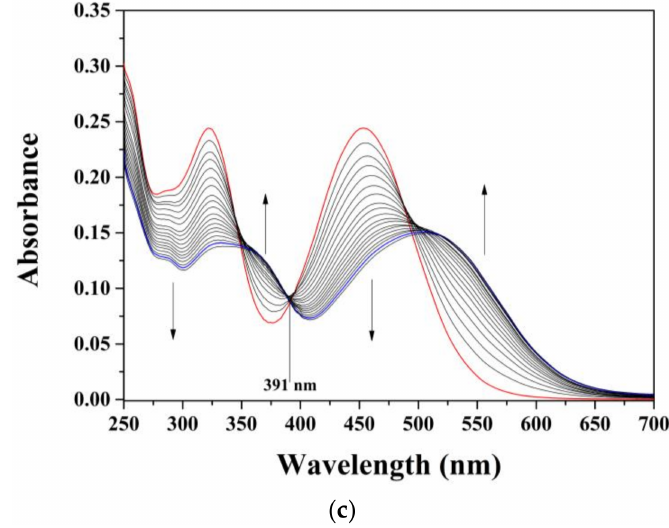
Figure 2. ( a ) Absorption variations of DPP (20 µ M) with cations (20 eq.). ( b ) Color variations of DPP (20 µ M) with different cations (20 eq.). ( c ) Absorption variations of DPP (20 µ M) with varied amounts of Ni 2+ (0–16 eq.).